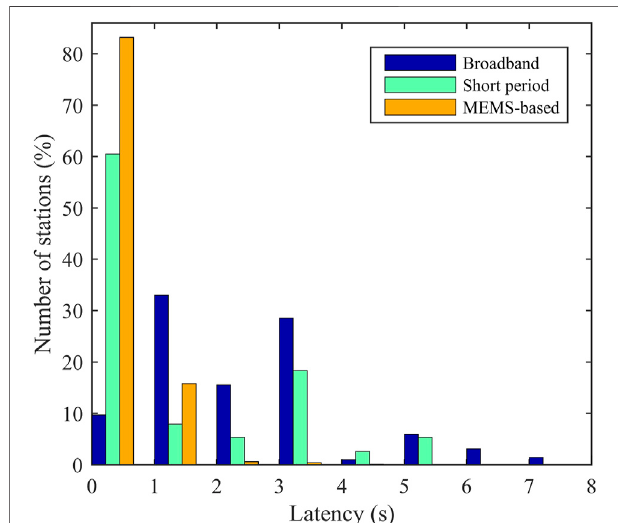
FIGURE 2 | Normalized data latency distribution (%) for the Sichuan SeismicNetwork.Heredistributionineachclassofinstrumentisnormalizedto its total number of sample. All MEMS-based stations sent 0.5 or 1.0 s data packets; fortheupgraded broadband andshort period seismic stations, they used the same low-latency data packetizing function as the MEMS- based stations and acquired data with data packetizing of 0.5 or 1.0 s; for the broadband and short period seismic stations not upgraded, they sent data after the data packet is full and compressed.